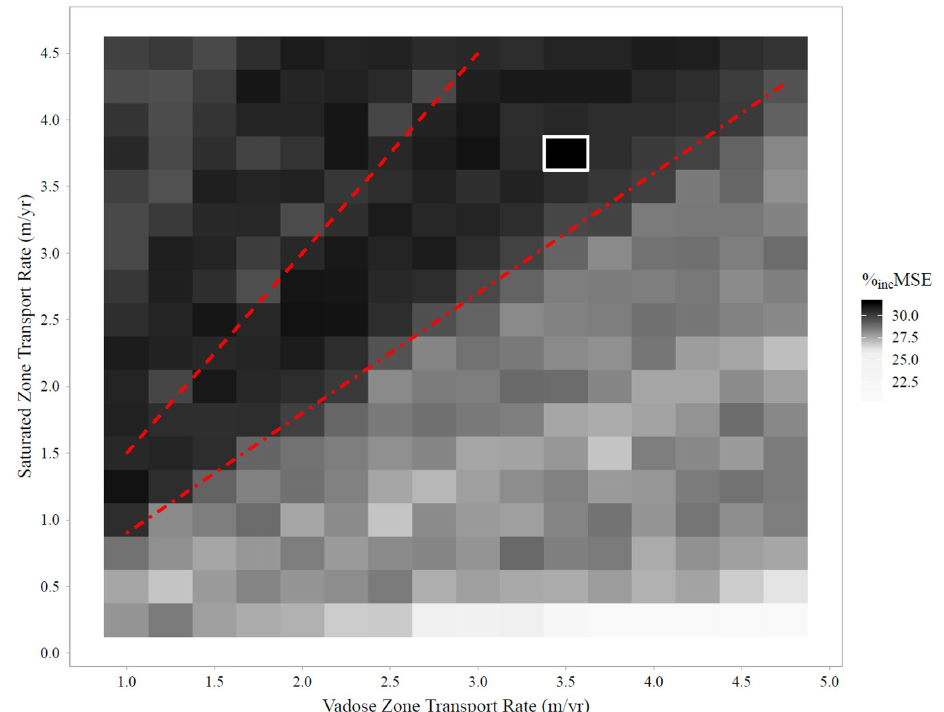
Figure 6. Heat map of % inc MSE (median from 25 models) from the variable importance of the total travel time for each of the 288 transport rate combinations evaluated. Red dashed lines indicate upper ( V s /V u = 1 . 5; long dashes) and lower (0.9; short dashes) bounds of the band of transport rate combinations with consistently higher % inc MSE. The white square highlights the single transport rate combination with the highest % inc